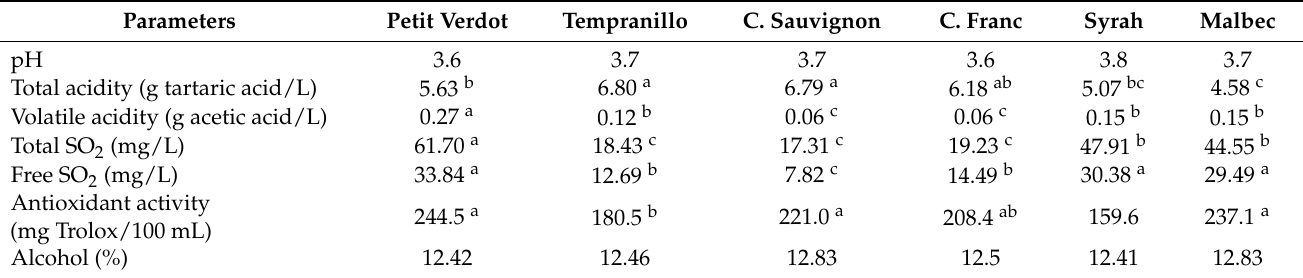
Table 3. Physicochemical parameters of the types of wines used in the